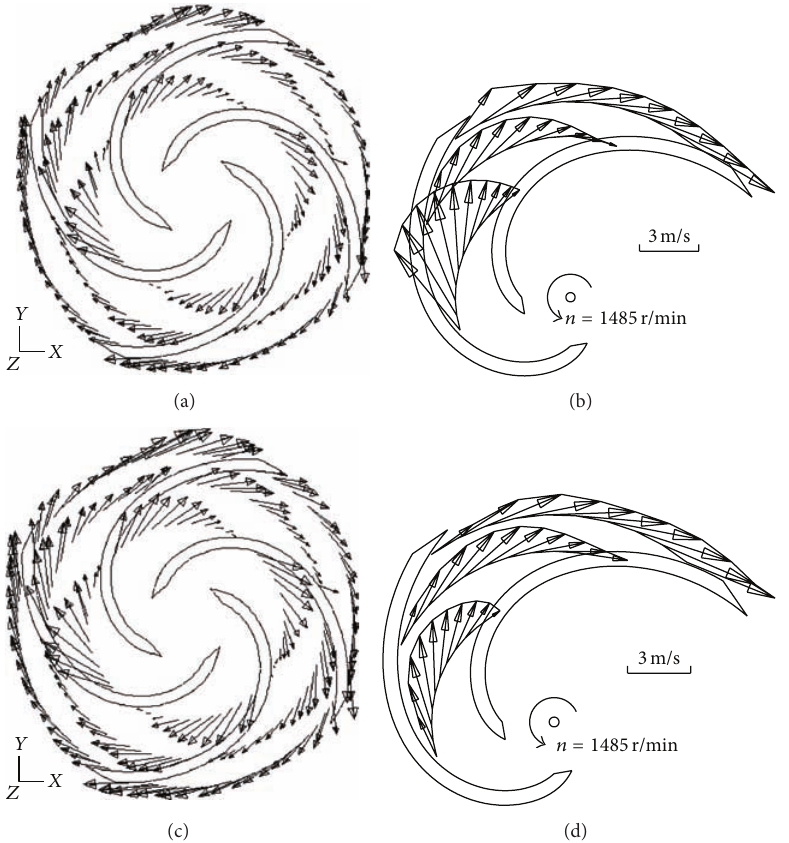
Figure 4: Relative velocity vectors in the impeller passages at BEP and Ra = 50 𝜇 m for water (1cSt) and oil (48cSt), (a) CFD, water, (b) LDV, water, (c) CFD, oil, and (d) LDV,